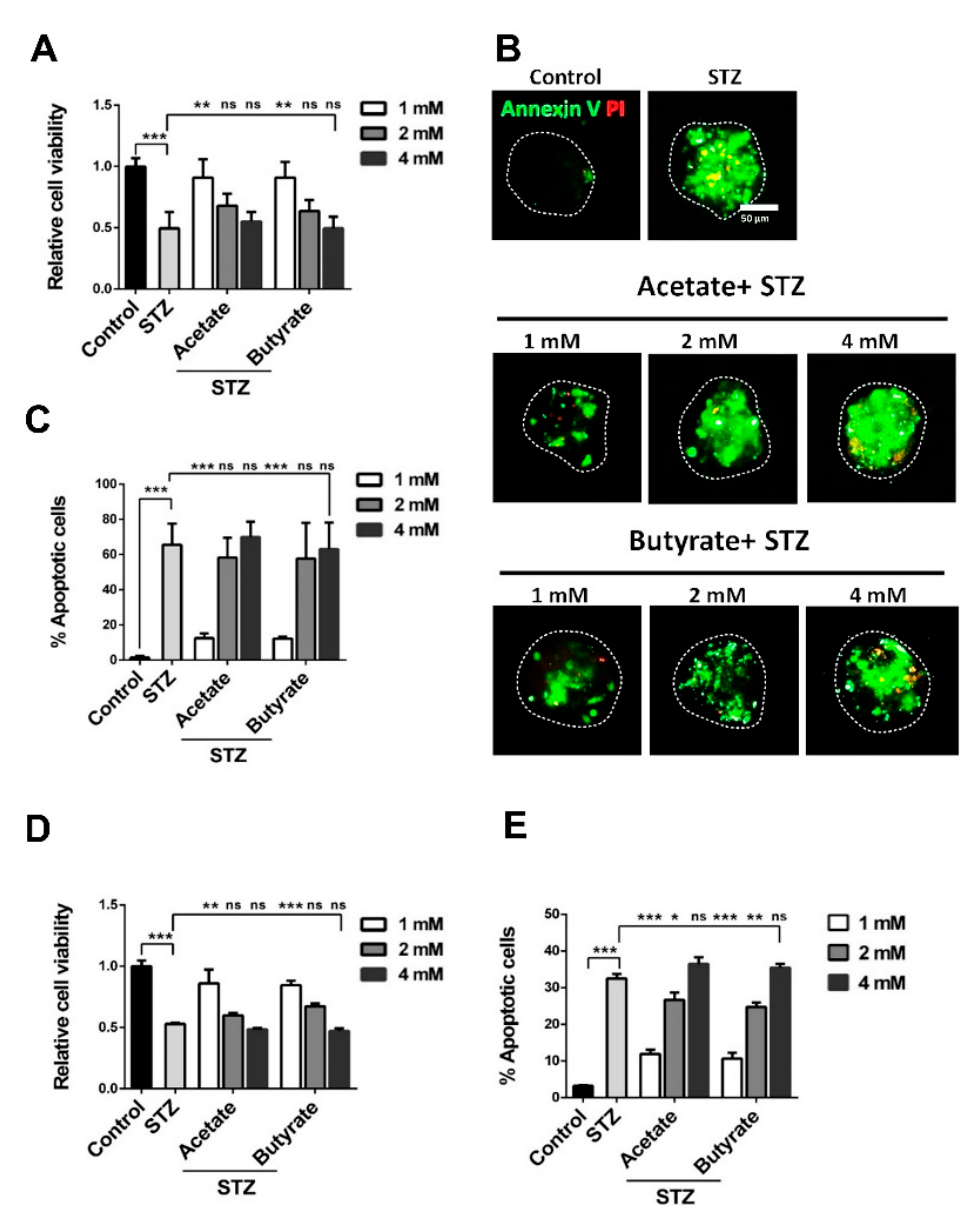
Figure 3. Effects of acetate and butyrate on viability and apoptosis in streptozotocin (STZ)-treated human islets and MIN6-cells. Following pre-incubation with the indicated concentration of acetate or butyrate for 1 h, islets and MIN6-cells were co-incubated with the tested short-chain fatty acids (SCFA) and 5 mM STZ for 24 h. ( A ) Islet cell viability was determined by WST-1 assay. ( B ) Islet cell apoptosis was detected by Annexin V and propidium iodide (PI) staining. Scale bar denotes 50 µm. ( C ) Islet Annexin PI staining results were analyzed by using Image J gradation analysis. Human islets were tested from 5 donors. ( D ) MIN6-cell viability was determined by WST-1 assay. ( E ) MIN6 cell apoptosis was detected using a flow cytometric assay with Annexin V and PI staining. Results are plotted as mean ± SEM ( n = 5). The statistical differences were quantified using one-way ANOVA analysis with Newman–Keuls multiple comparisons test (* p < 0.5, ** p < 0.01, *** p < 0.001); ns, not significant.